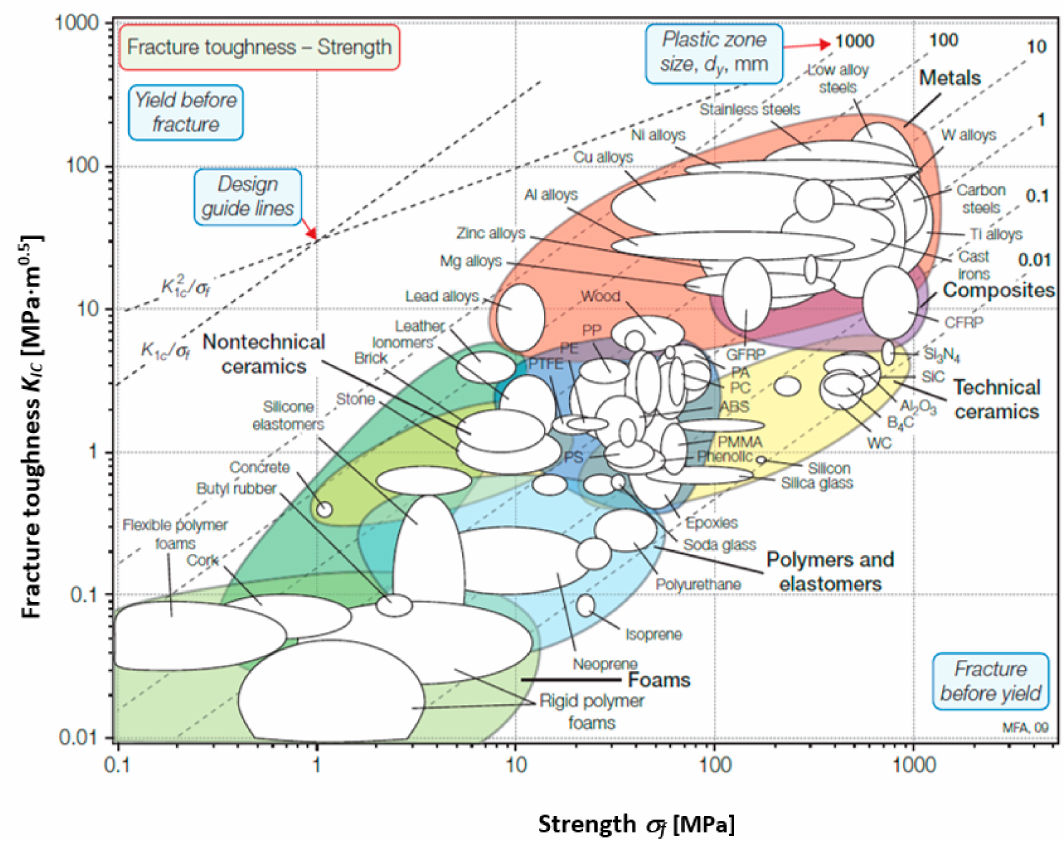
Figure 1. Fracture toughness versus strength [5].